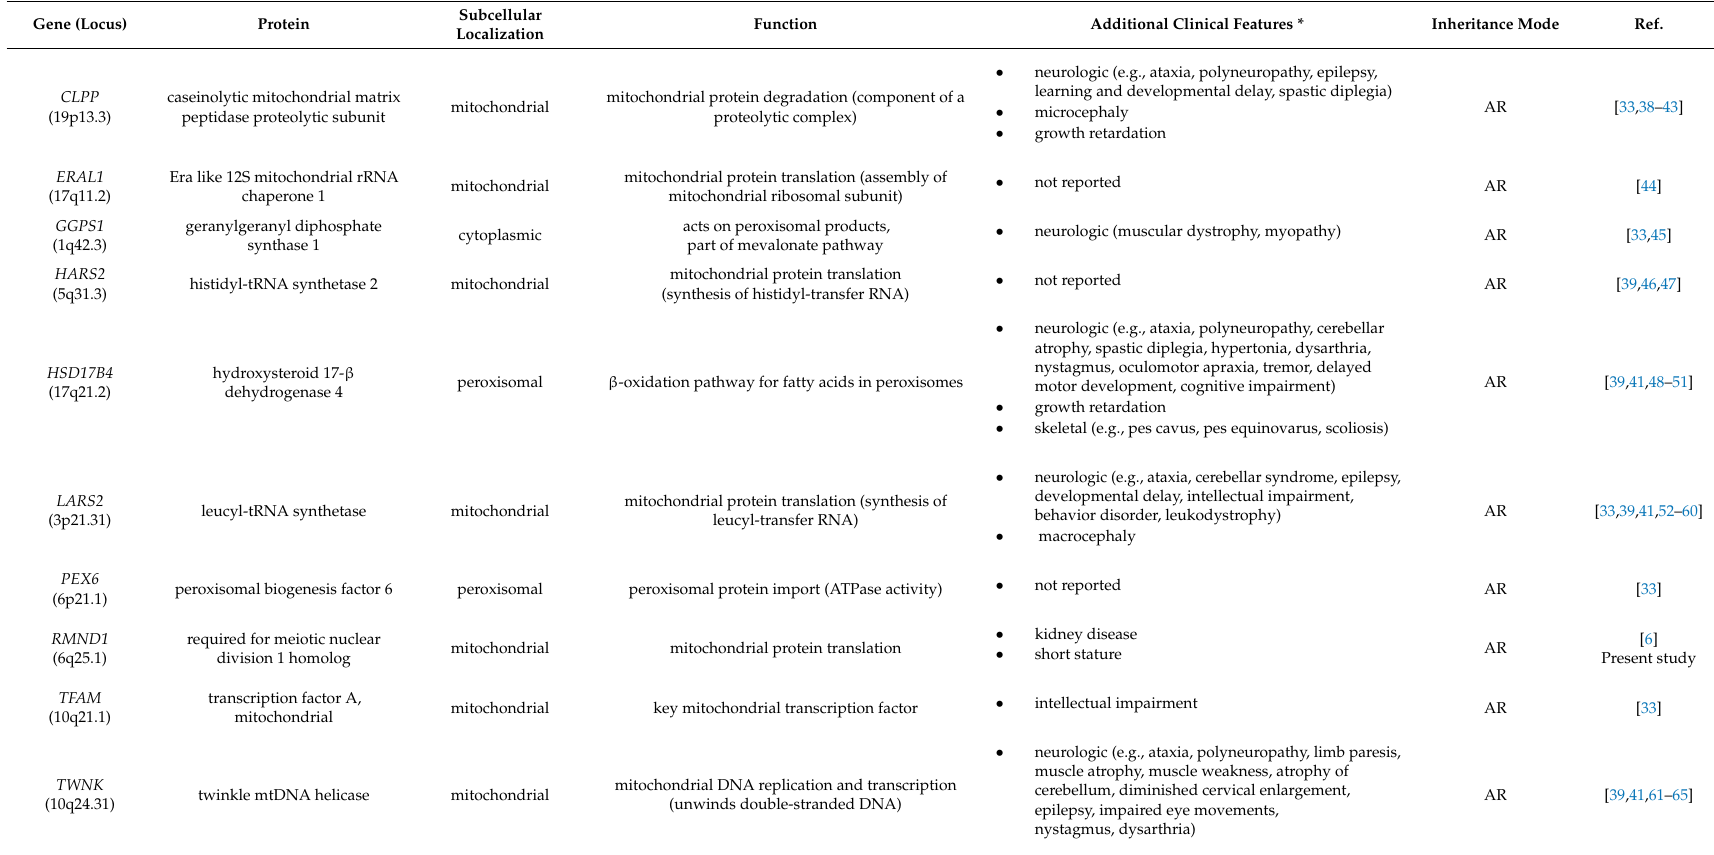
Table 3. Genes causally involved in the development of PRLTS and PRLTS-like